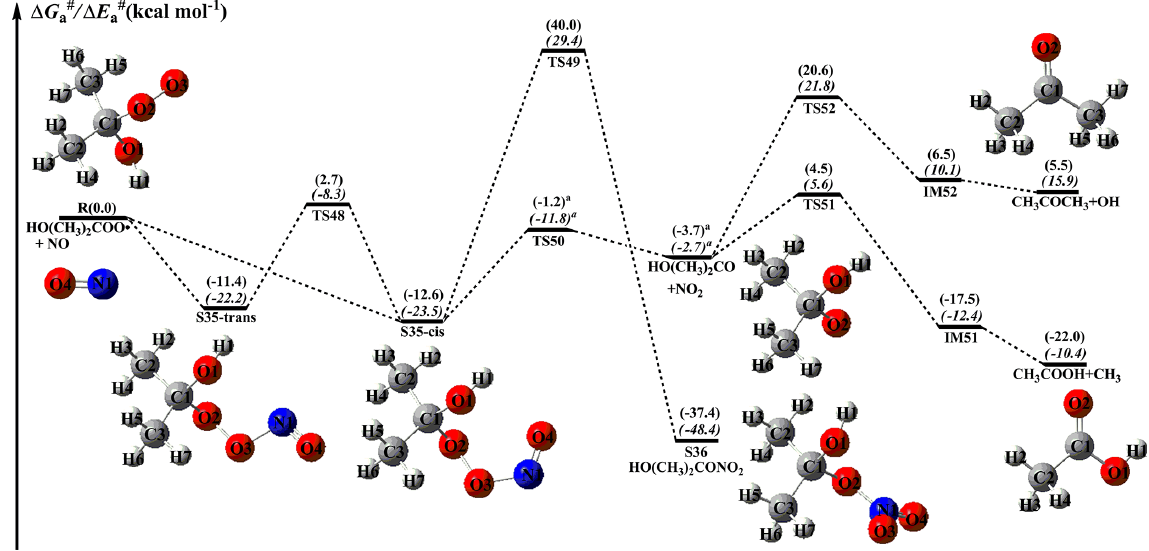
Figure 12. PES ( (cid:49)G # a and (cid:49)E # a , in italics) for the reaction of an HO(CH 3 ) 2 COO radical with NO predicted at the M06-2X/ma-TZVP//M06- 2X/6-311+G(2df,2p) level of theory (the superscript a is calculated at the MP2/ma-TZVP//MP2/6-311+G(2df,2p)